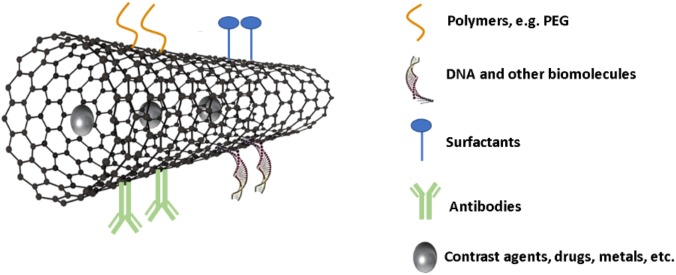
Schematic representation of surface functionalization and loading of carbon nanotubes for biomedical applications.